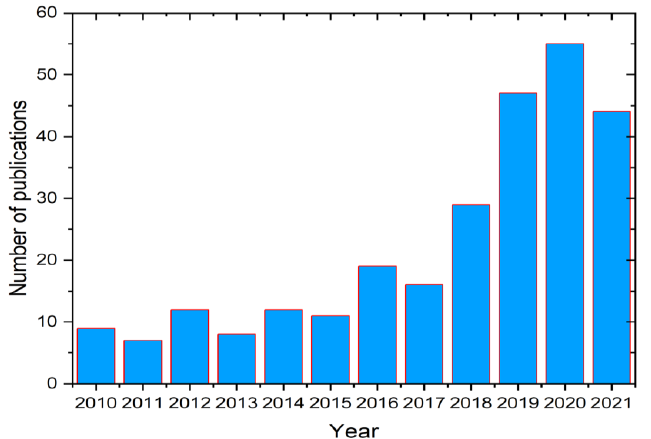
Figure 1. A bar graph shows journal articles published between 2010 and 2021 on “ USRP ” from the Web of Science. Web of